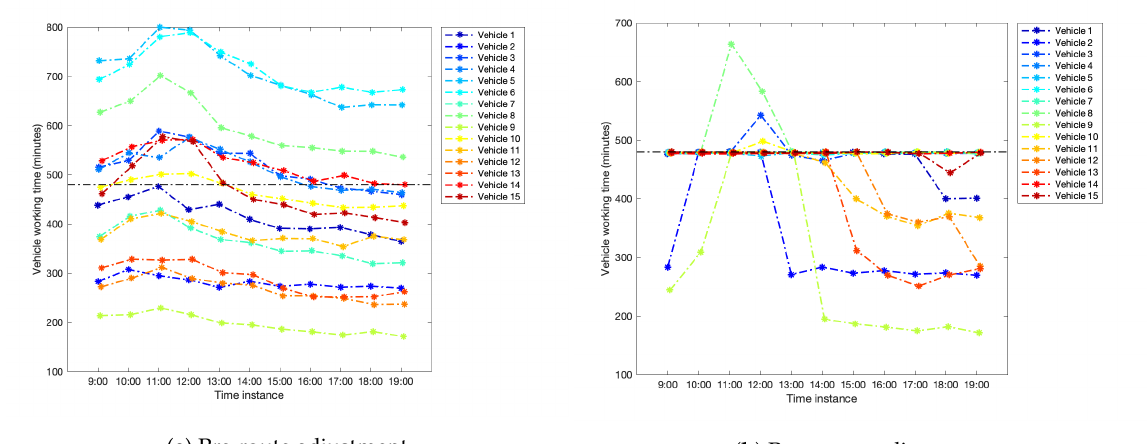
Figure 6. Pre- and post-route adjustment obtained before and after applying Algorithm 2 for problems in Scenario B at time instances between 9 a.m. and 7 p.m. The black dashed line displays the working time limit of 480